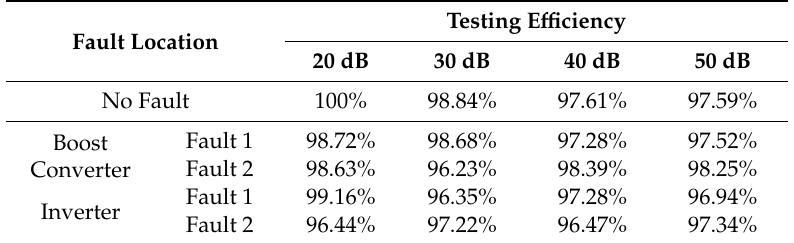
Table 4. Testing e ffi ciency for various faults under di ff erent noise